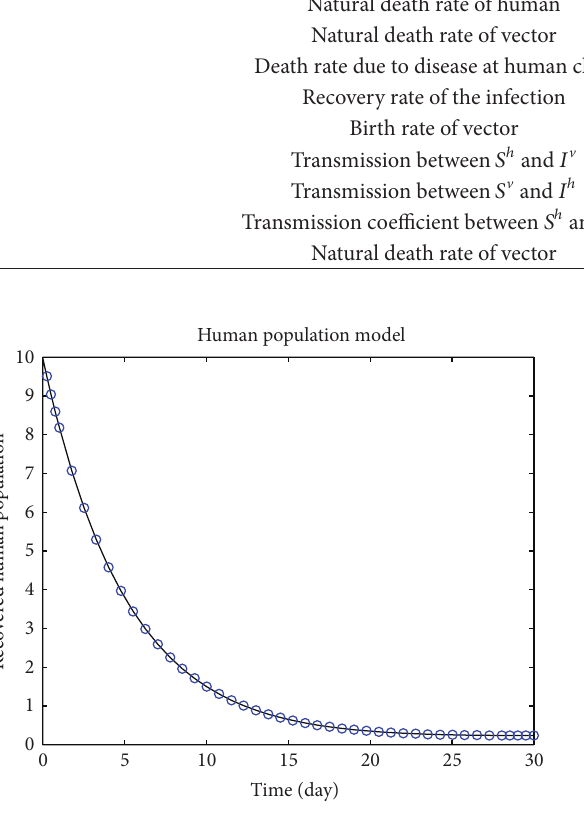
Figure 5: Comparison of RK method (dotted line) and MSGDTM (solid line).